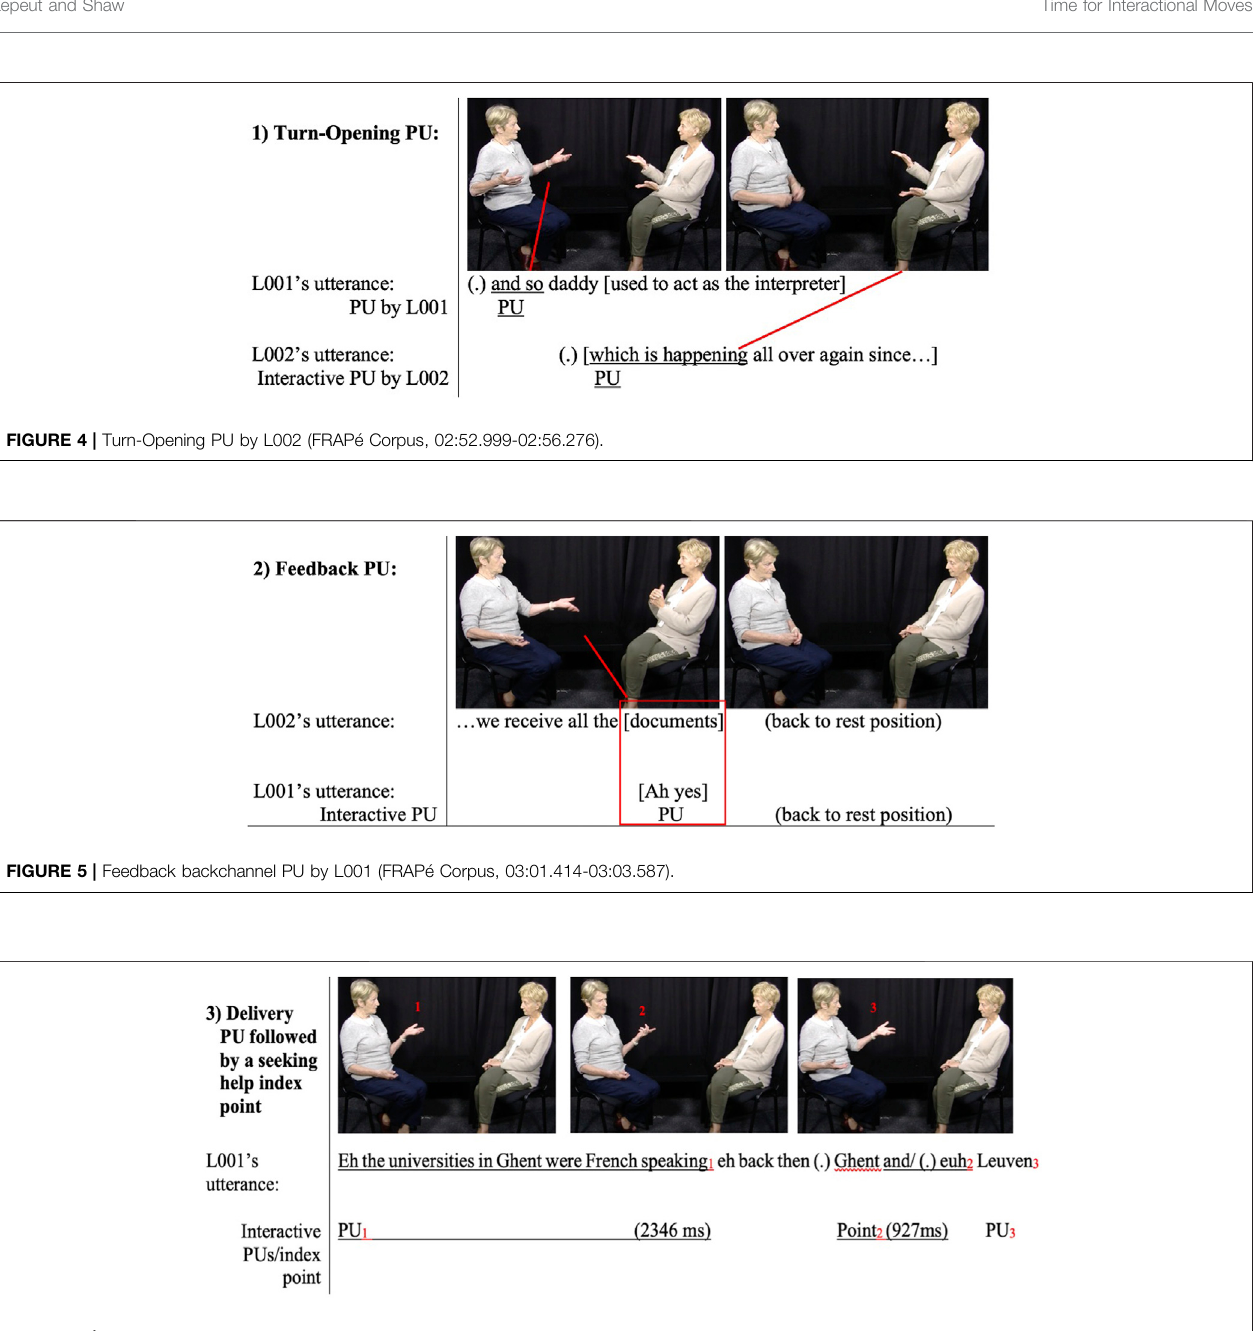
Frontiers in Communication |